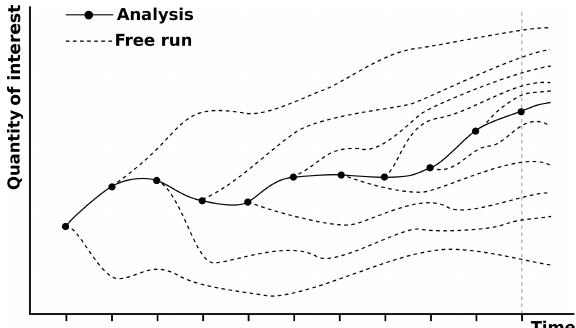
Figure 4. Determination of the TM5 correlation field. The solid line is an assimilation model run, the dashed lines are 10 day free model runs. After 10 days, there are 11 ozone fields for each given day which can be used to determine the